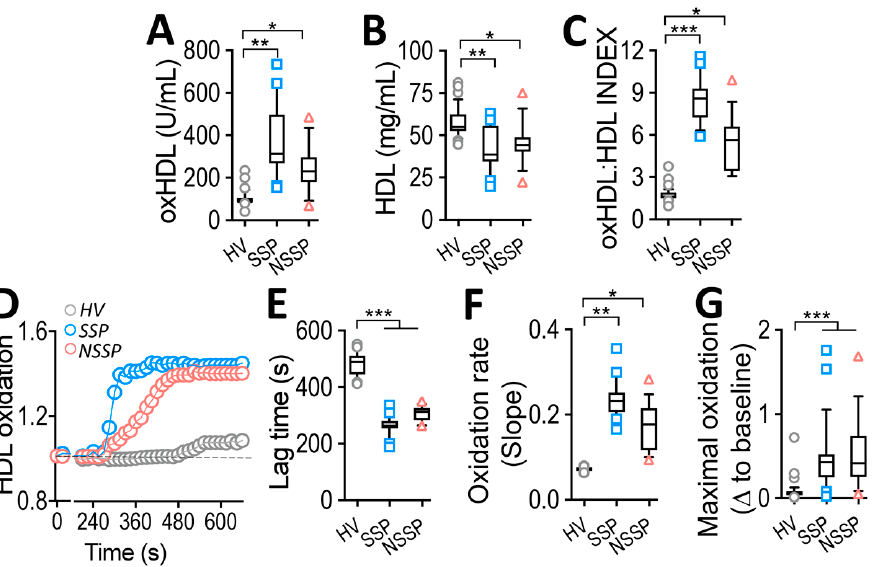
Figure 1. HDL and oxHDL plasma levels in SSP and NSSP and oxidation kinetic parameters. ( A – D ) Blood samples were collected from HV (grey circle), SSP (blue square) and NSSP (red triangle) to measure plasma levels of oxHDL ( A ), HDL ( B ) and INDEX ( C ). ( D ) Representative traces for HDL time-lapse oxidation progression from native HDL obtained from HV (grey circles), SSP (red circles) and NSSP (blue circles). ( E – G ) Determination of lag time ( E ), oxidation rate ( F ) and maximal oxidation ( G ) for native HDL obtained from HV (grey circles), SSP (red circles) and NSSP (blue circles). Statistical differences were assessed by a one-way analysis of variance (ANOVA) (Kruskal–Wallis) followed by Dunn’s post hoc test. * p < 0.05, ** p < 0.01, *** p < 0.001. Values are expressed as the median ± 10–90 percentile.